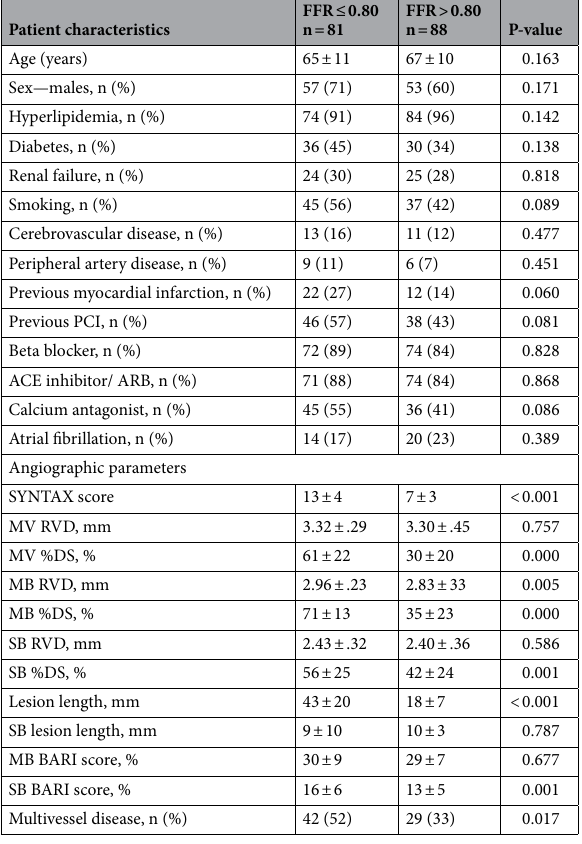
Table 1. Patient’s demographic and angiography characteristics. All BARI score—percentage area at risk of left ventricle, based on all stenoses equal or more than 50% in diameter; MB BARI risk score—percentage area at risk supplied from a main branch of interest; SB BARI score—percentage area at risk supplied from a side branch.